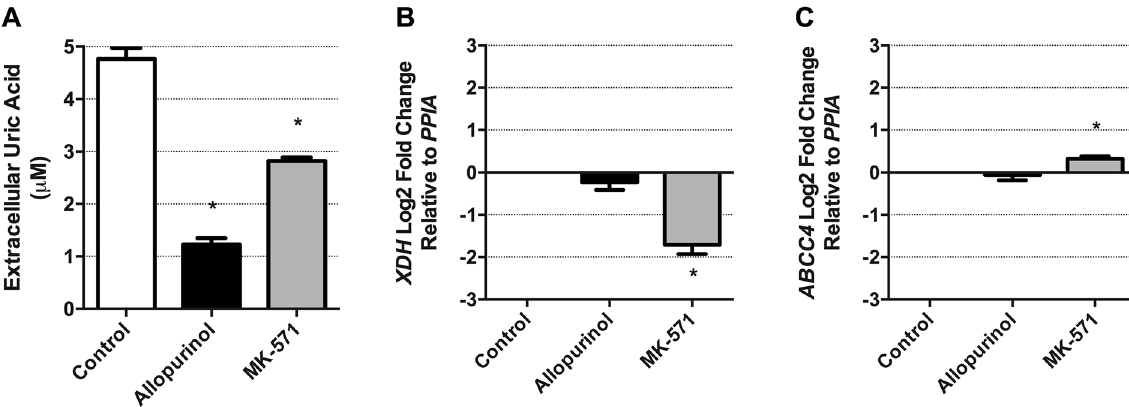
Fig 3. Extracellular uric acid levels from human airway epithelial cells can be attenuated with the XDH inhibitor, allopurinol, and the ABCC4inhibitor, MK-571. (A) Allopurinol (500 μ M) and MK-571 (20 μ M) treatment for 24h attenuatedun-stimulated productionof uric acid from HBEC-6KT, a human airway epithelialcell line derivedfrom a healthyindividual. (B) XDH and (C) ABCC4 gene expressionin HBEC-6KT cells. Data represent mean +/- SD, n = 3. Significance is representedby * = p < 0.05relative to control.